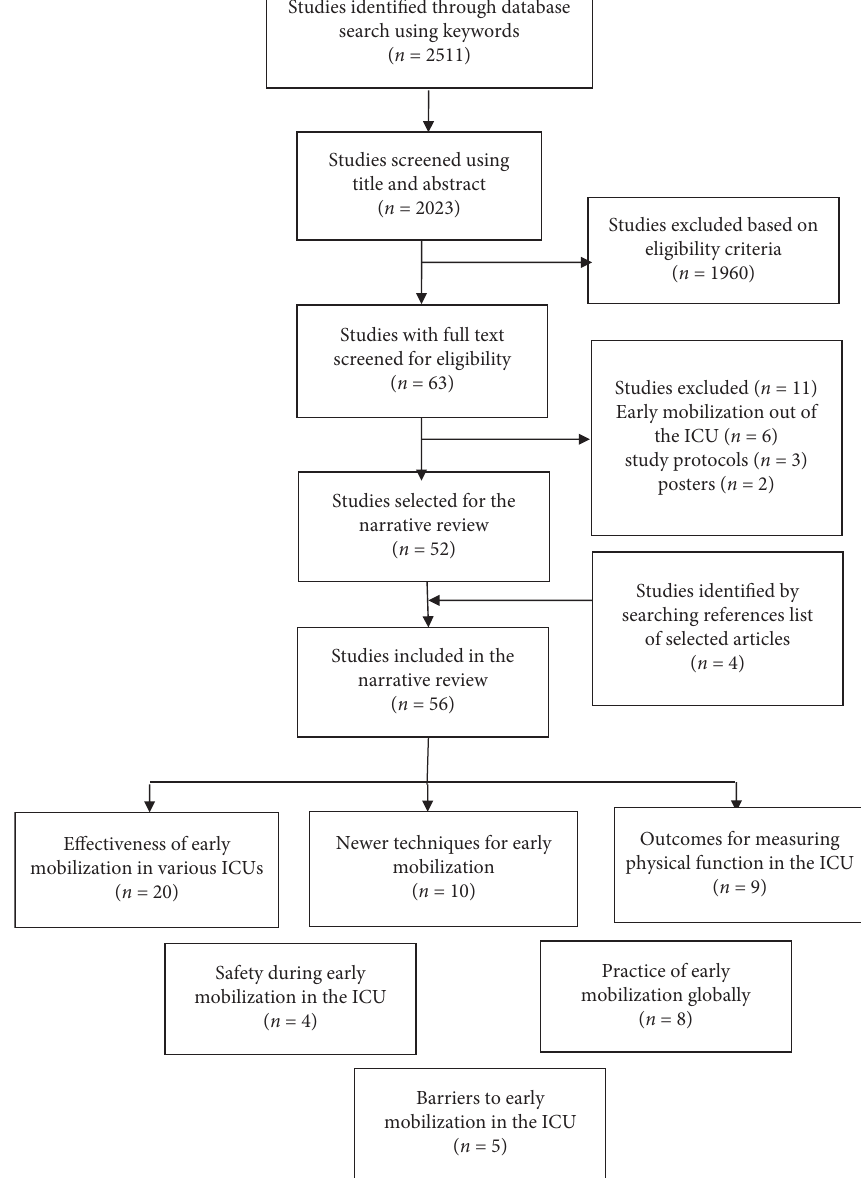
Figure 1: Flow diagram showing data